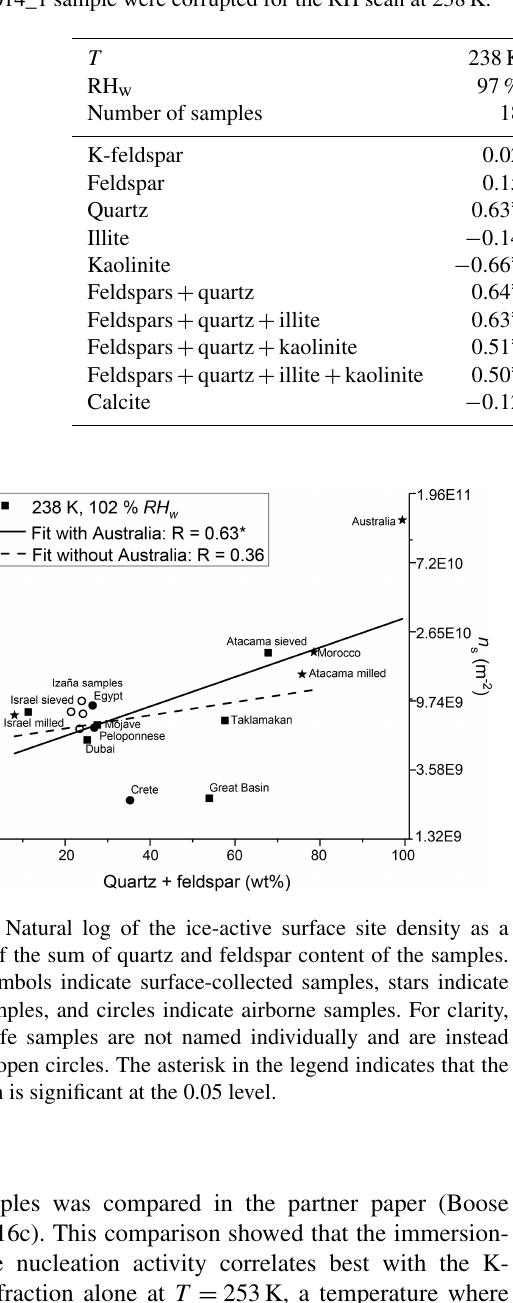
Table 2. Overview of the Pearson correlation coefficients of the sum of selected mineral fractions and ln (n s ) at different temperatures. An asterisk indicates that the correlation was significant at the 0.05 level. K-feldspar comprises microcline and orthoclase, while feldspar refers to the sum of microcline, orthoclase, and plagioclase. The number of samples included in each correlation varies, because the n s of the Mojave, Peloponnese, and Tenerife2014_2 samples was below the detection limit at 242K, and the size distribution measurements of the Tenerife2014_1 sample were corrupted for the RH scan at 238K.